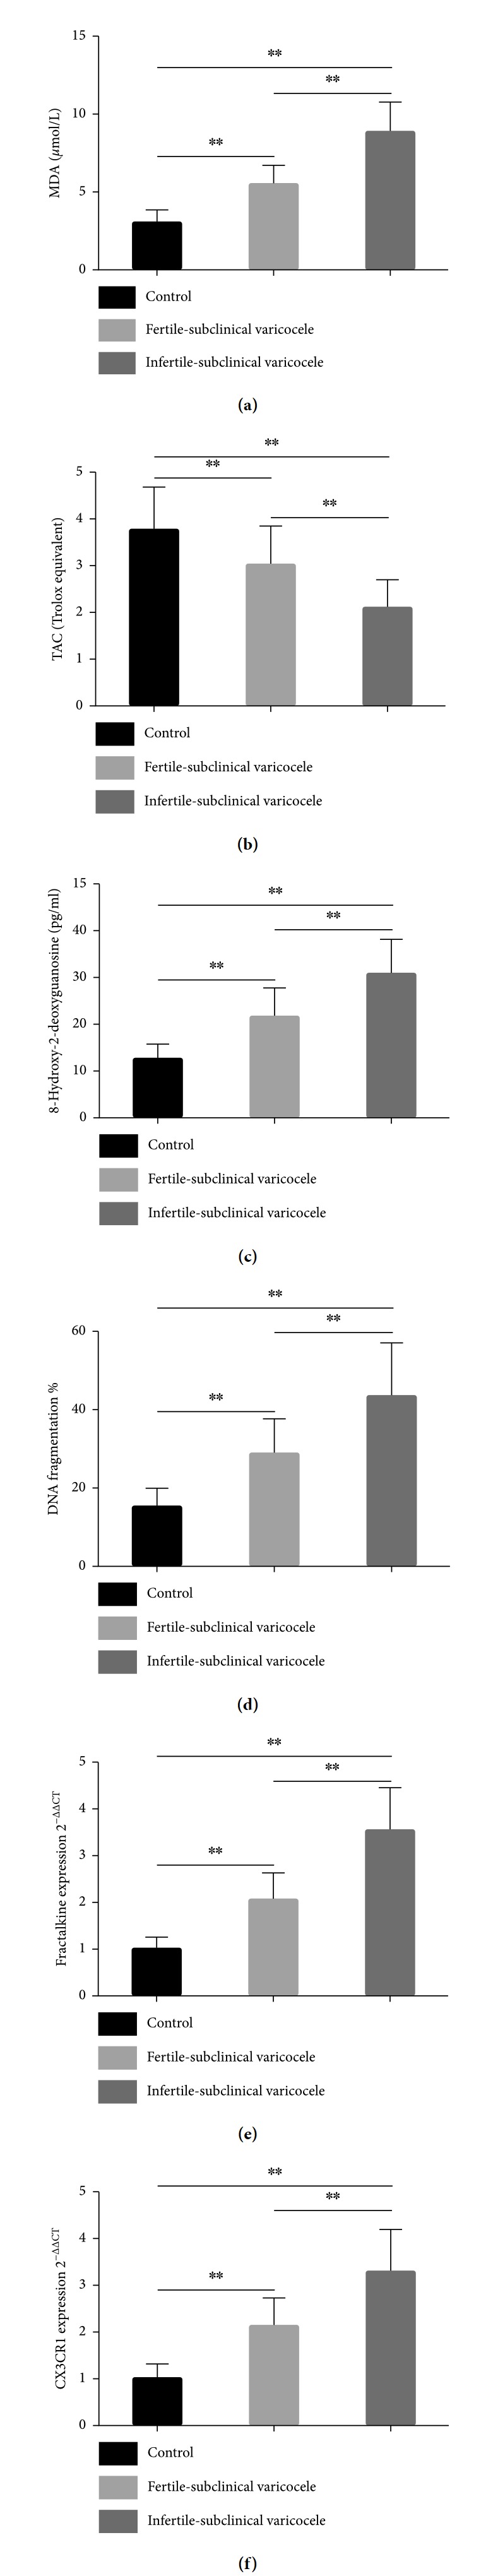
Oxidative stress state, DNA fragmentation, and fractalkine expression in subclinical varicocele patients. (a) Levels of MDA. (b) TAC. (c) 8-OHdG level. (d) DNA Fragmentation. (e) Fractalkine gene expression. (f) CX3CR1 gene expression. Data are represented in the form of mean ± SD. ∗
p < 0.05, ∗∗
p < 0.005, ∗∗∗
p < 0.0005.